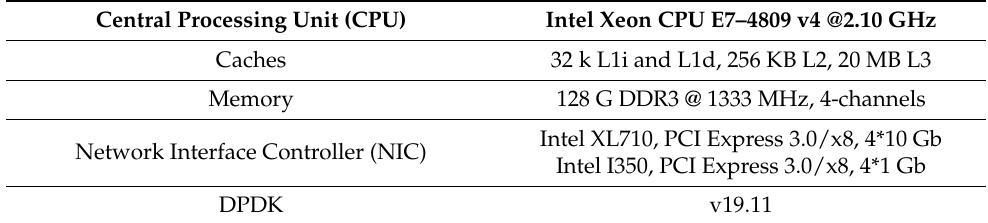
Table 4. System under test data